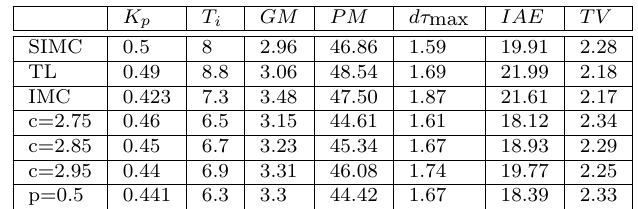
Table 3: PI-controller settings for an integrating